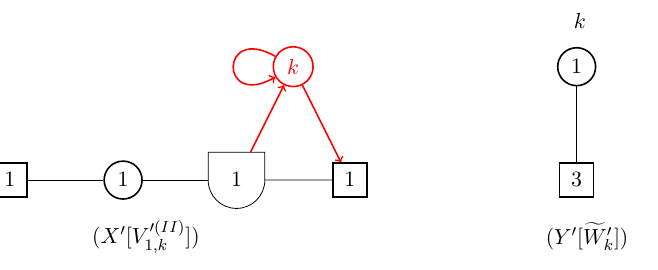
Figure 24 . The second realization of the vortex defect in the theory X 0 via a 3d-1d system.